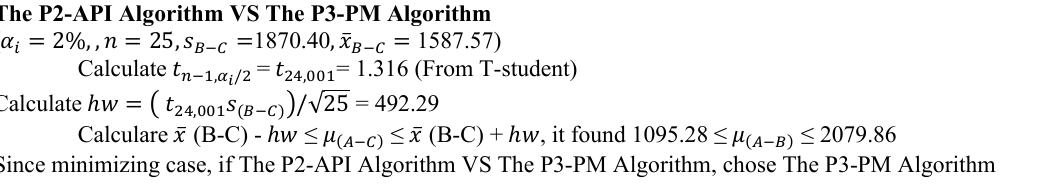
The P2-API Algorithm VS The P3-PM